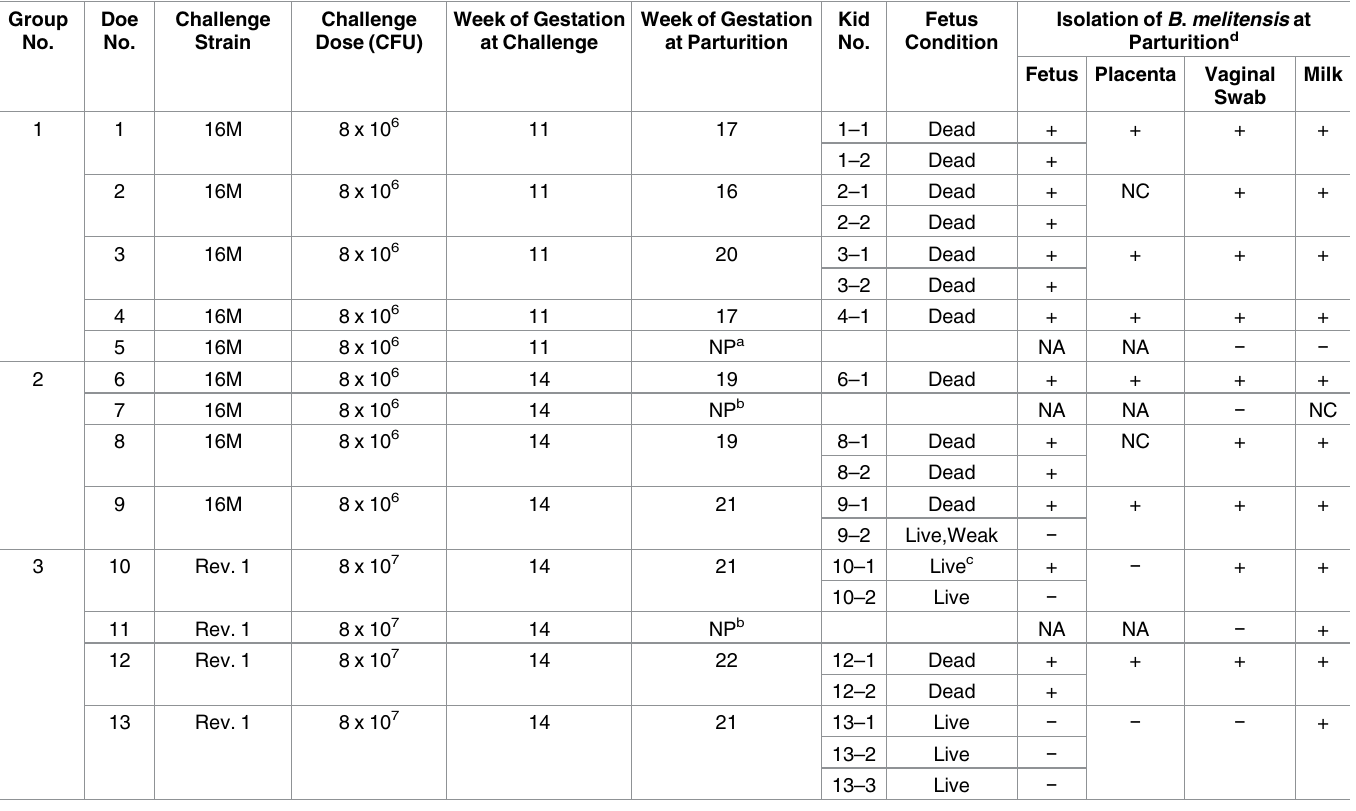
Table 1. Effect of B . melitensis 16M and Rev. 1 on parturition in goats. Group Doe No.